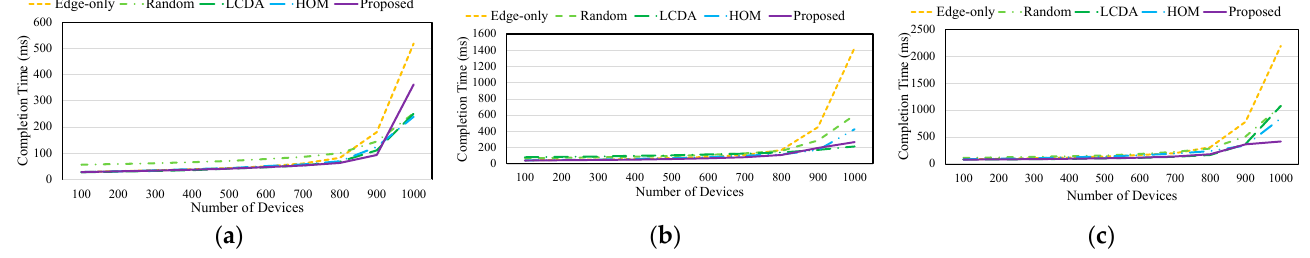
Figure 8. Completion time of Task 1, Task 2, and Task 3: ( a ) Task 1; ( b ) Task 2; ( c ) Task 3. HOM calculates the shortest path according to the network bandwidth and task